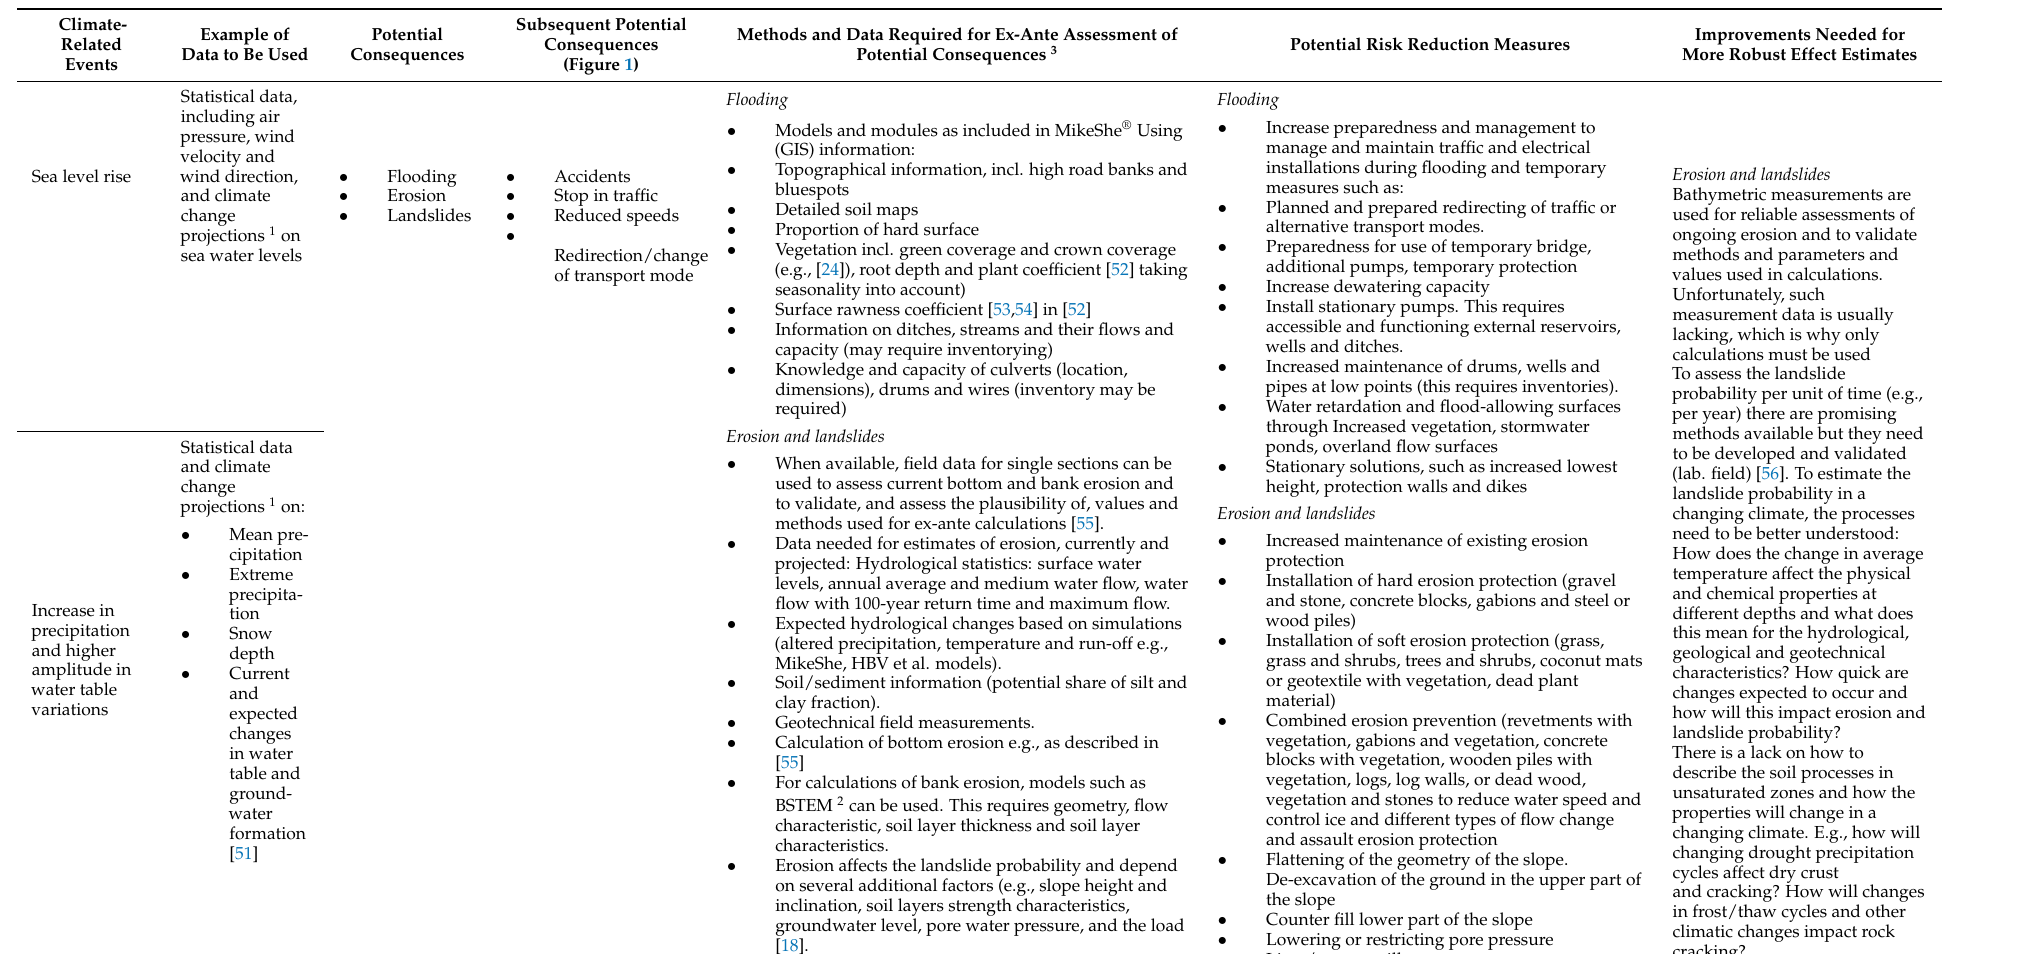
Methods and Data Required for Ex-Ante Assessment of Potential Consequences